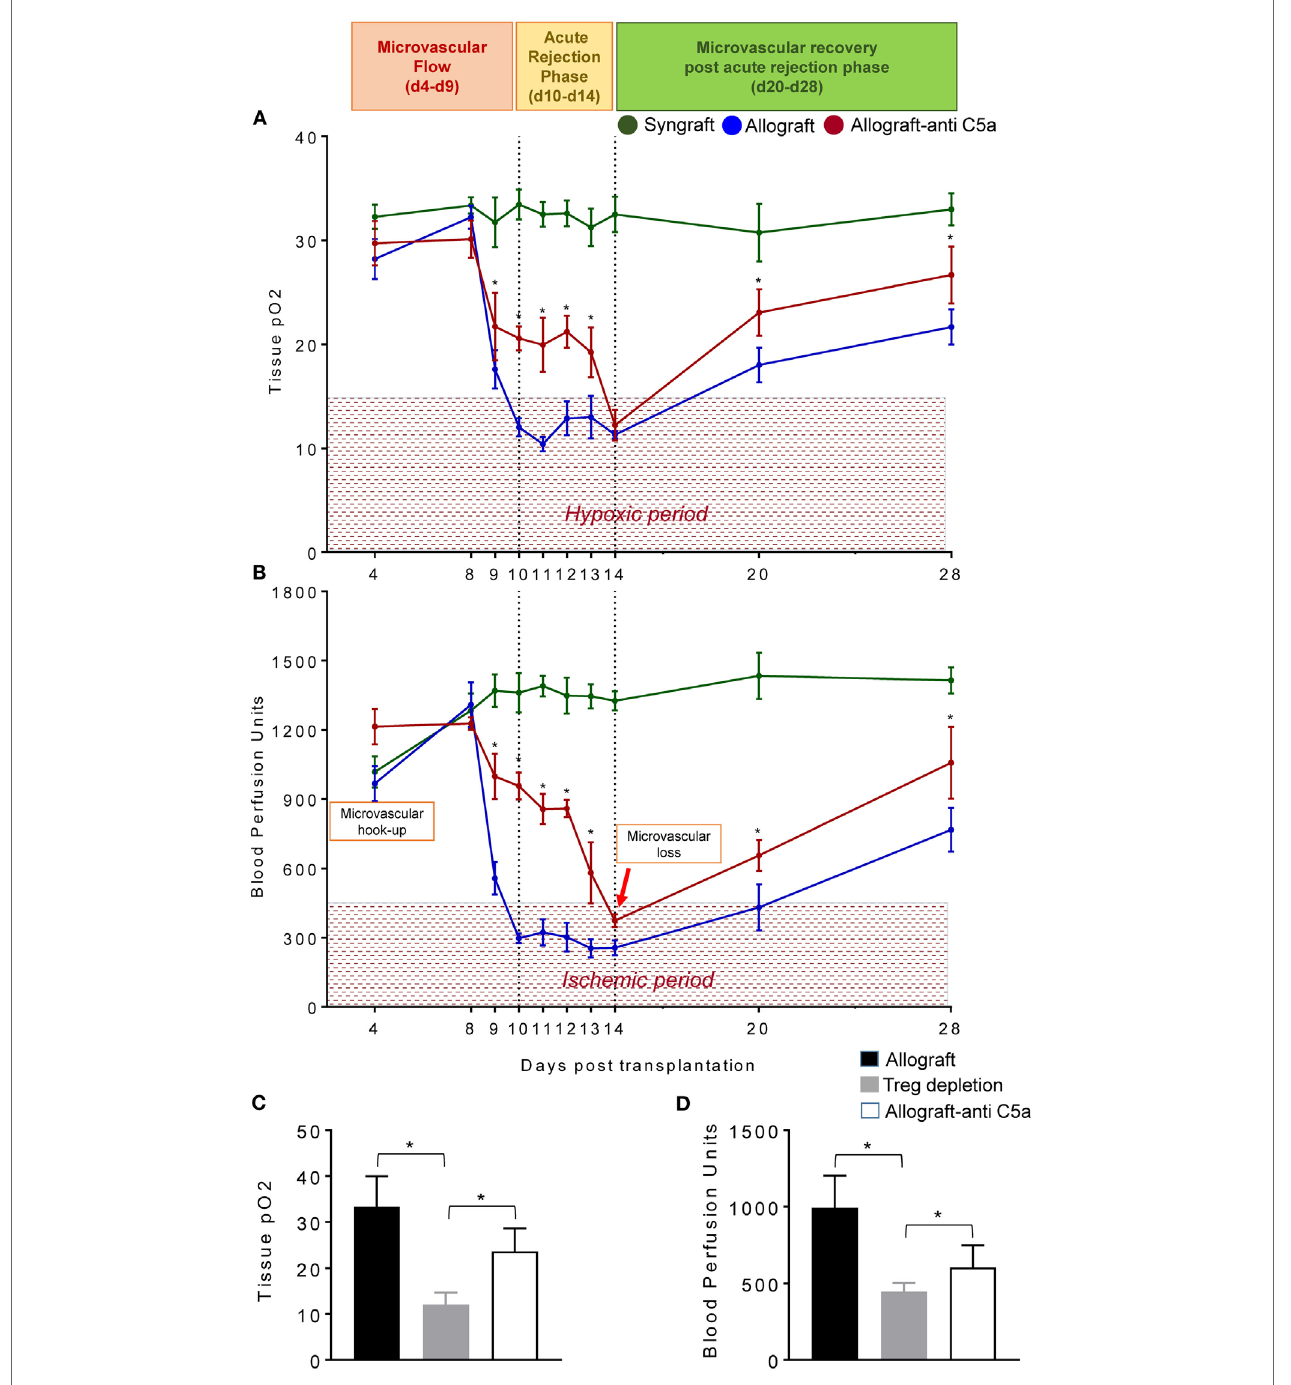
FigUre 4 | C5a-mediated regulatory T cell (Treg) induction improves tissue pO 2 , blood perfusion. (a) Tissue pO 2 (mean ± SE, mmHg) and (B) blood perfusion (mean ± SE, units) were plotted over different time points (d4–d28). (c,D) Tissue pO 2 and blood perfusion were plotted in untreated, Treg depleted, and anti- C5a-treated transplants at d8 posttransplantation. Data are presented as means with SE of 4–6 transplants/time point/experiment, and repeats of three different experiments. * p <